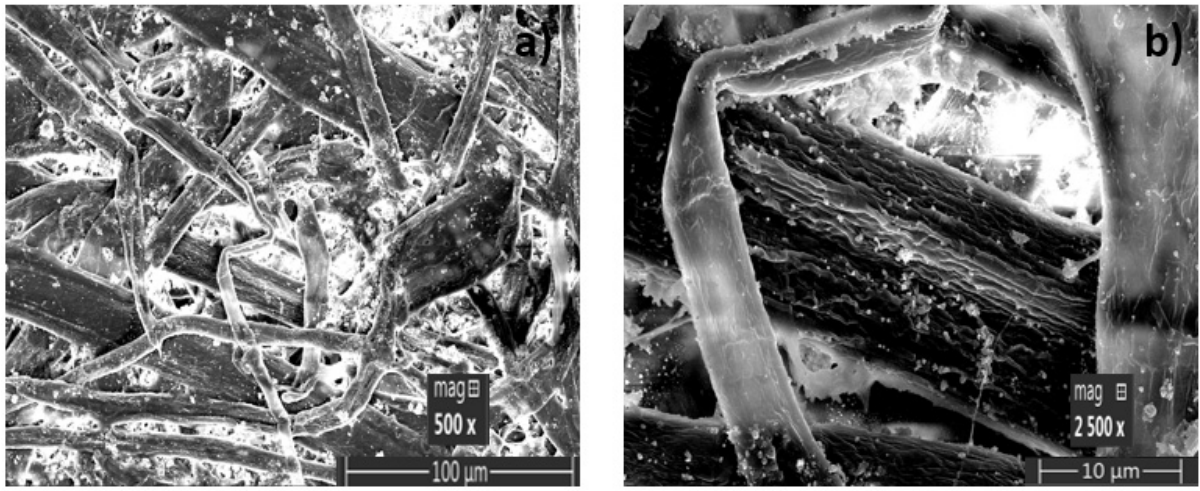
Figure 2. Top-view scanning electron microscope images with different magnification: ( a ) 500×—scale bar 100 µm, and ( b ) 2500×—scale bar 10 µm, for the C–Ag nanocomposite thin films deposited on the copy paper substrates.